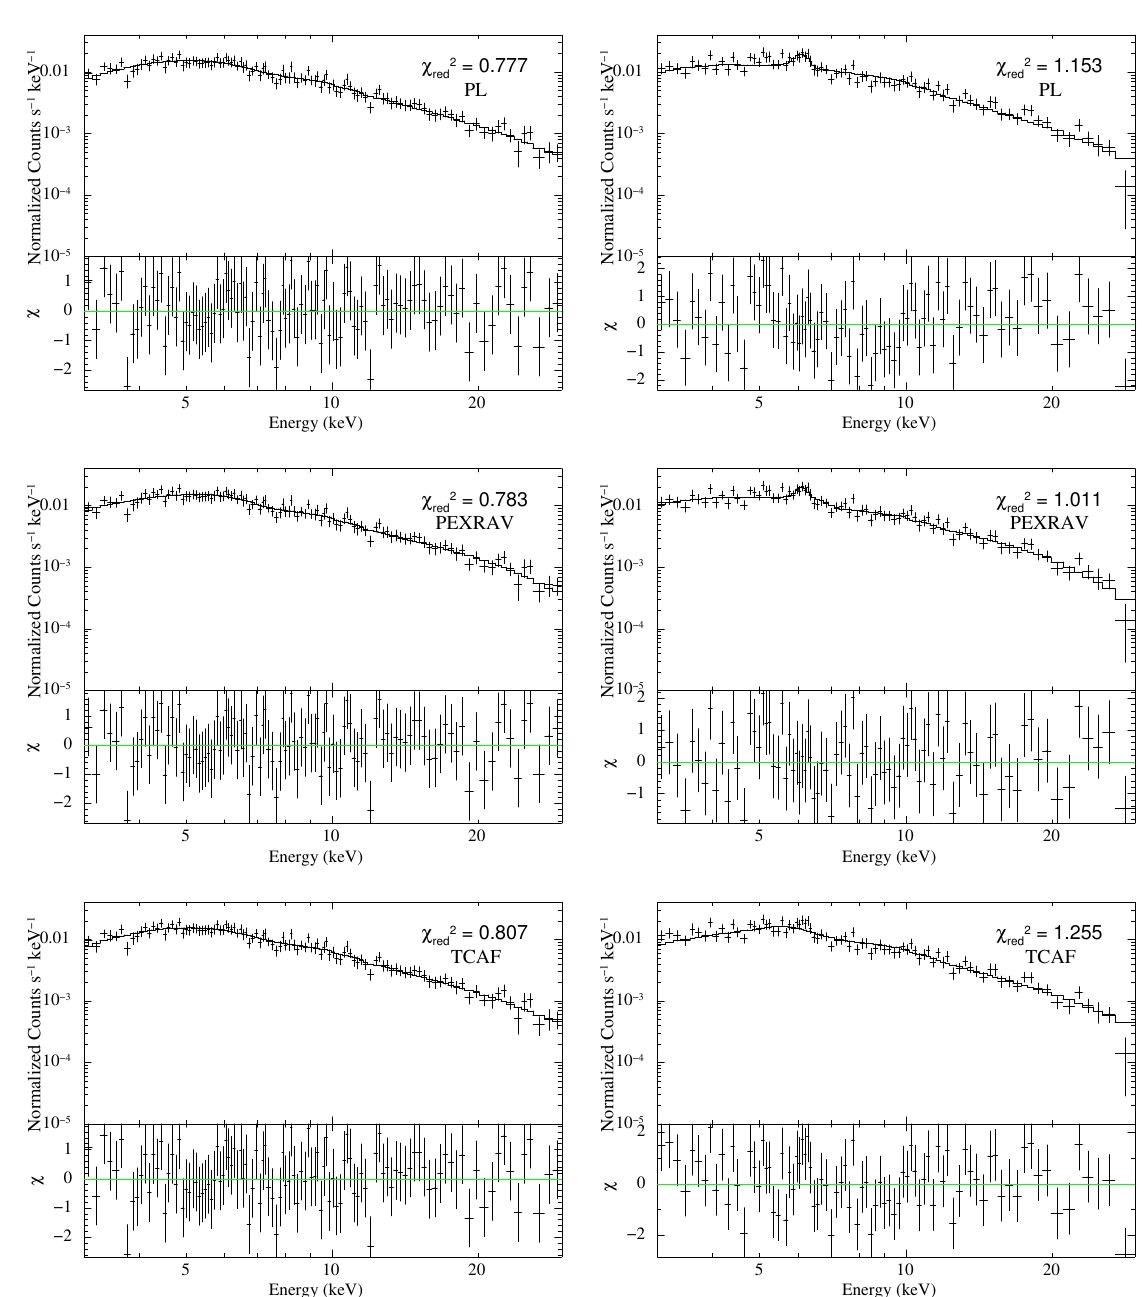
Figure A2. Same as Figure 2 but for the OBSIDs 90602619006 ( left panel ) and 90602619008 ( right panel ) along with the